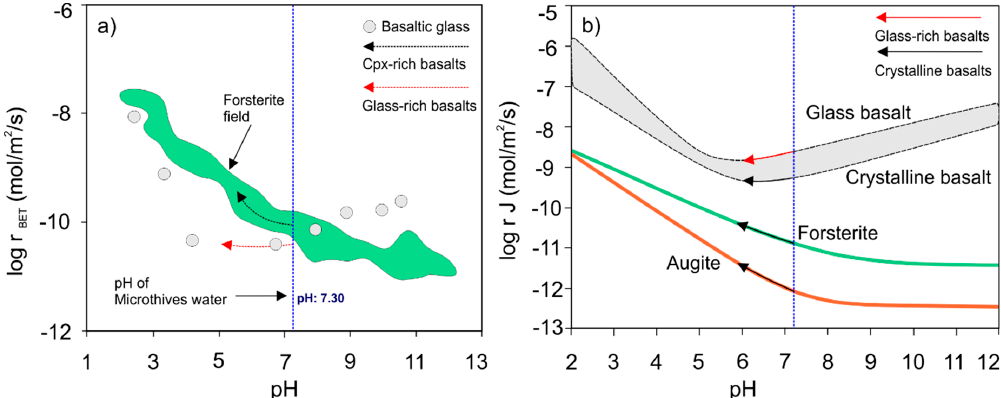
Figure 5. ( a ) Modified diagram of t he dissolution rate of the forsterite ( T : 25 °C; [64]) and basaltic glass ( T : 30 °C) [65] vs. pH. The dissolution rate is normalised to the BET surface area of the dissolving mineral and glass grains. ( b ) Modified diagram [68] of the dissolution fluxes (mol m − 2 s − 1 ) at T : 25 °C of crystalline and glassy basalts. Forsterite and augite dissolution rates taken from [63].